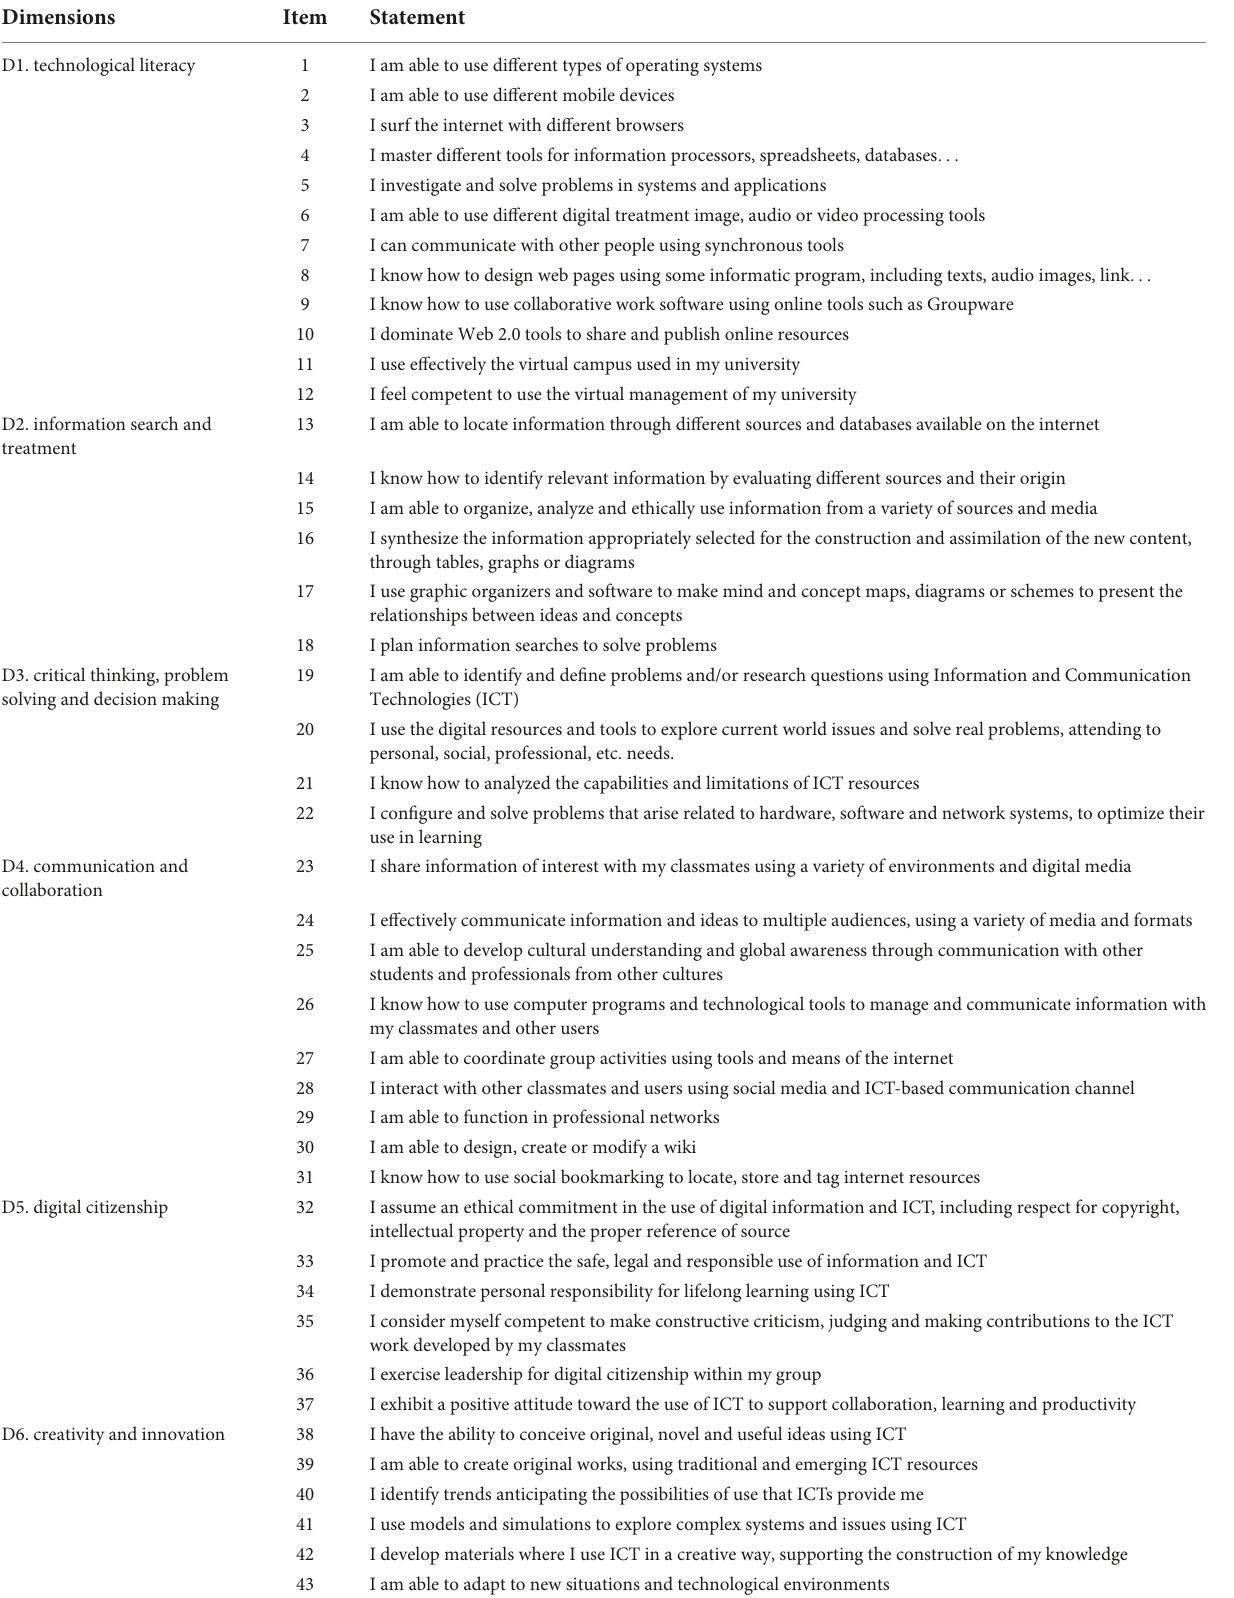
TABLE 5 Description of the statements related to digital competence questionnaire for higher education students (CDAES) (adapted from Gutierréz-Castillo et al., 2017). Dimensions